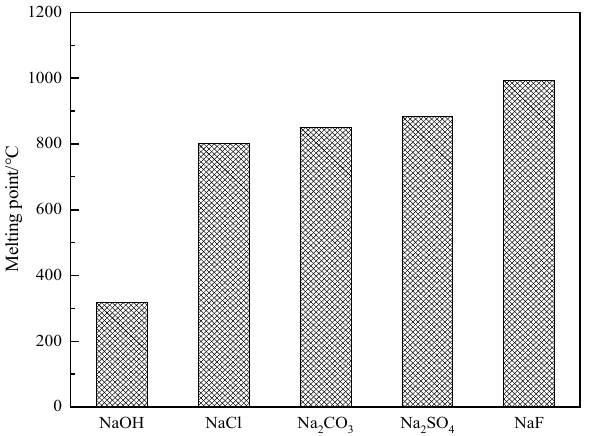
Figure 3. The melting points of different sodium additives.